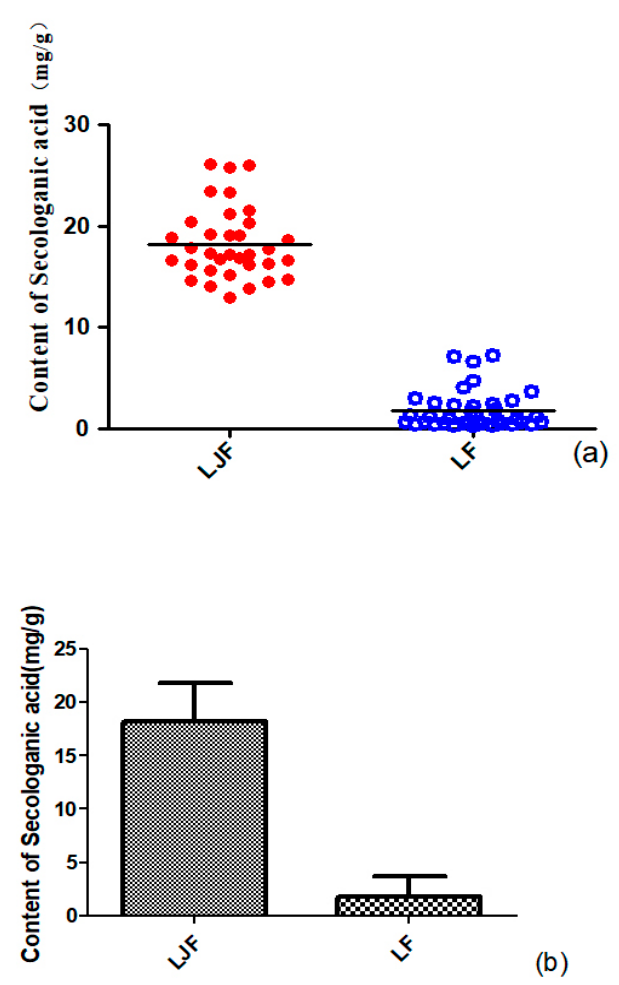
Figure 7. Scatter plot acquired from LJF and LF samples ( a ) and the contents of secologanic acid in LJF and LF ( b ) ( x -axes show LJF and LF, the different sample; y -axes have the content of secologanic acid).